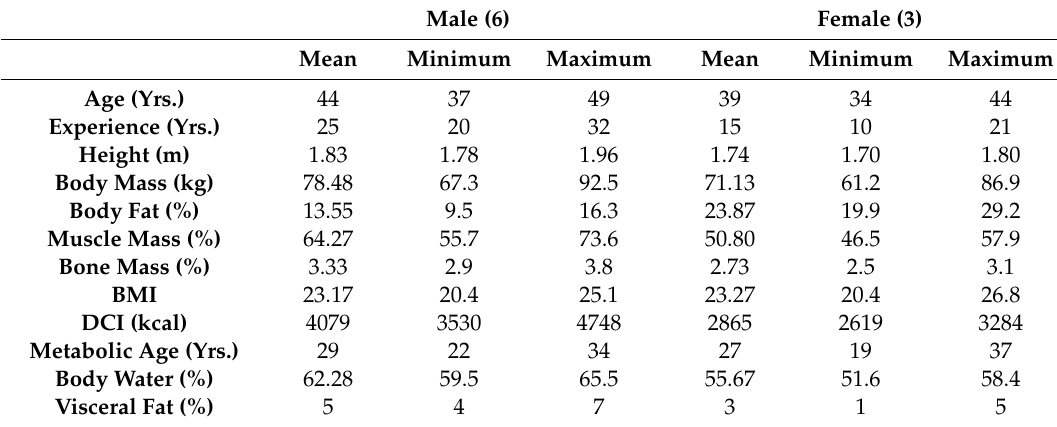
Table 1. Anthropometric and demographic data of referees (N =